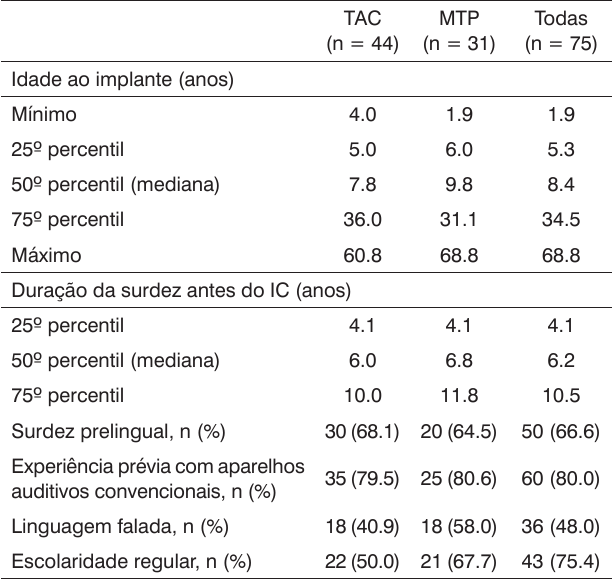
Tabela 1. Características basais dos 75 pacientes submetidos às duas abordagens para o implante